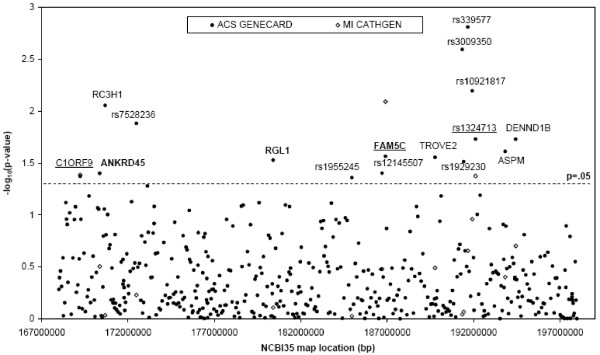
Chromosome 1 peak-wide mapping of genes involved in myocardial infarction. 457 SNPs were genotyped across the 1 LOD down region of linkage on chromosome 1 in the GENECARD ACS sample. Association was assessed using APL. The -log10 of the p-value is plotted according to chromosome position (closed circles). Markers with a p-value less than 0.05 fall above the dashed line; labels identify these genes and intergenic SNPs. Markers in bold exhibited modest evidence for linkage (LOD ≥ 1) in two point analysis. Sixteen markers that were associated (p ≤ 0.05) in the GENECARD ACS sample were genotyped in a MI case-control population (open circles). Markers which show replication are underlined.